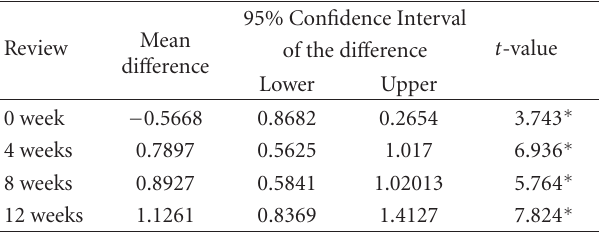
Table 5: Comparisons of VAS Pain mean score between group A and group